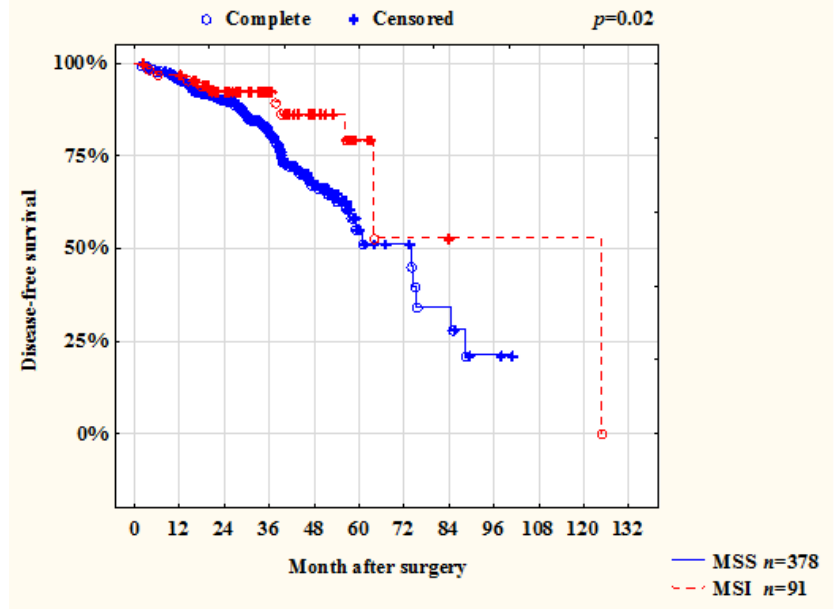
Figure 2. Disease-free survival of patients with CRC (stages I–IV) depending on the status of microsatellite instability.